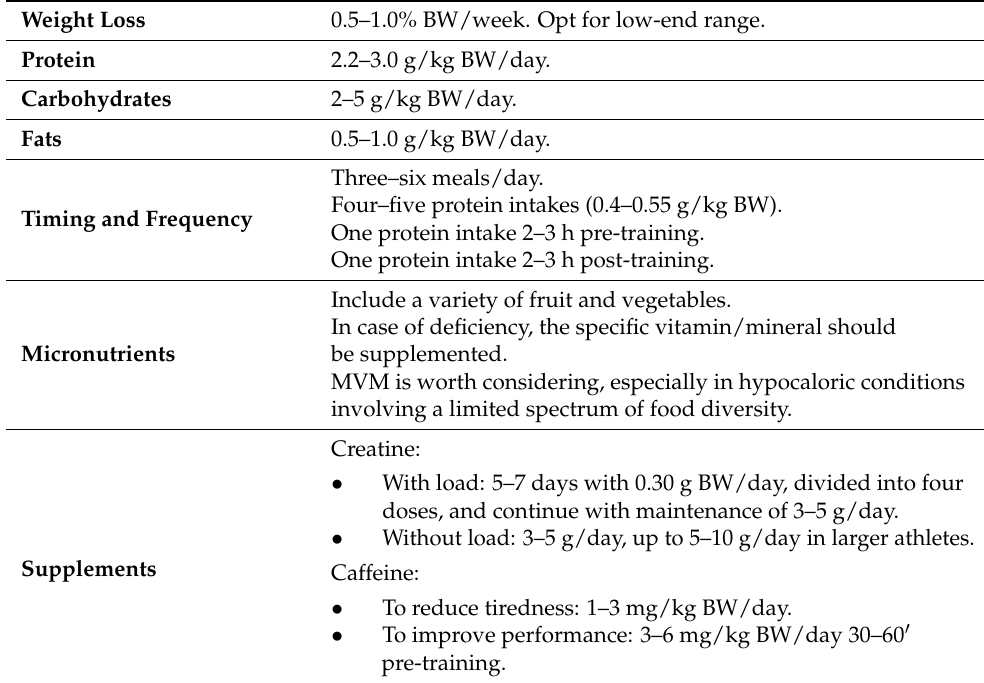
Table 1. Summary of dietary–nutritional recommendations for natural bodybuilding. Source: com- piled by